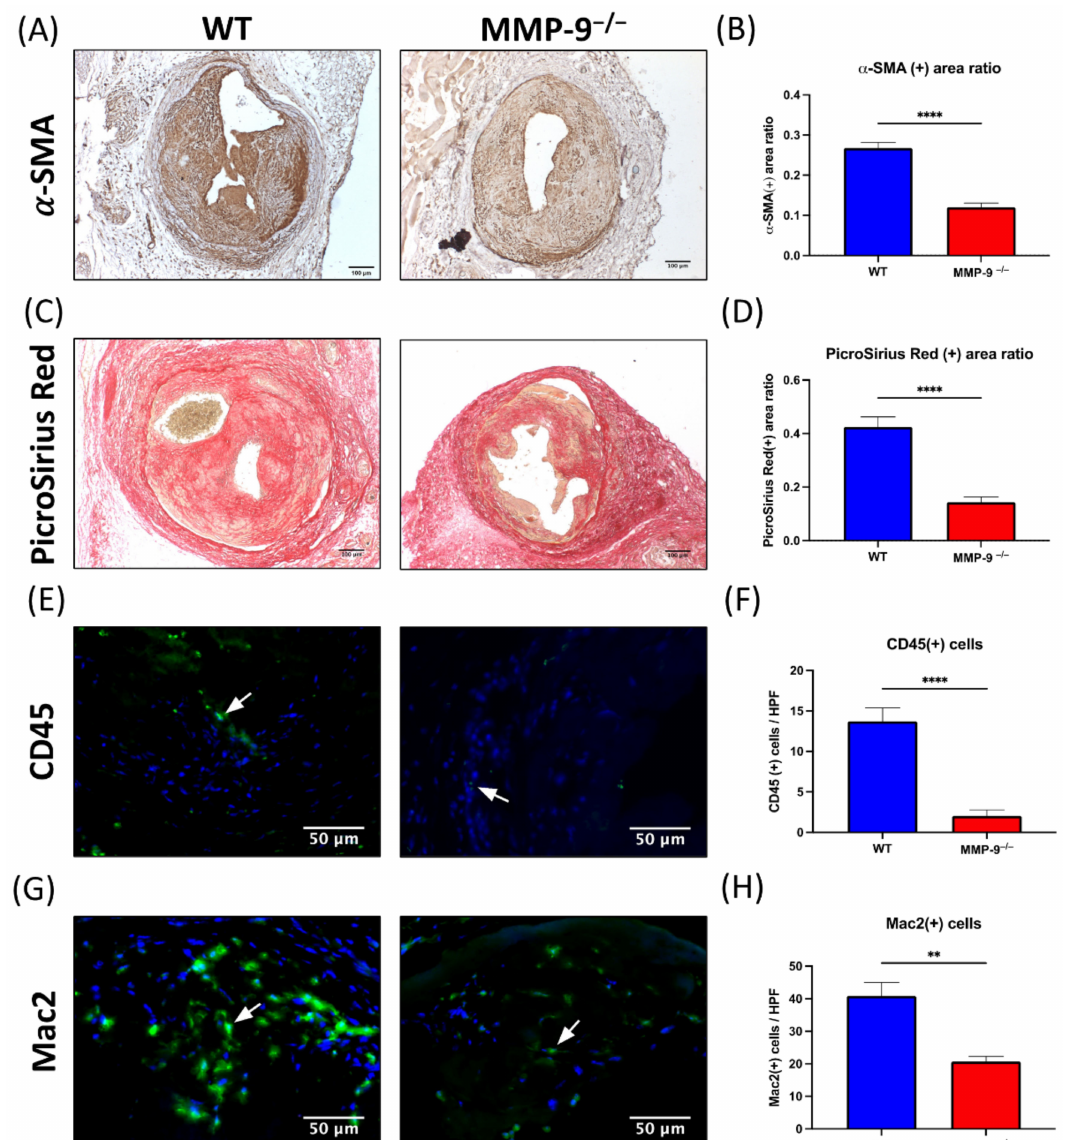
Figure 4. Matrix metalloproteinase 9 (MMP-9) knockout reduced α -smooth muscle actin ( α -SMA) antibody and Picro Sirius stained area, and CD45(+) and Mac2(+) cells in neointima of AV fistula venous segment. ( A ) α -SMA(+) cells were the major cellular component within neointima. ( B ) The α -SMA(+) area ratio in neointima reduced after MMP-9 knockout ( p < 0.0001). ( C ) Extracellular component of neointima was assessed with Picro Sirius Red staining. ( D ) The Picro Sirius Red(+) area ratio within neointima decreased in MMP-9 − / − mice ( p < 0.0001). ( E ) Leukocyte infiltration within neointima was determined by CD45 immunofluorescence. ( F ) MMP-9 deletion decreased CD45(+) cells/HPF in neointima ( p < 0.0001). ( G ) Macrophages in the neointima was examined by Mac2 immunofluorescence. ( H ) The number of Mac2(+) cells/HPF decreased in MMP-9 − / − mice ( p = 0.0011). White arrows indicated positively stained cells. ** p < 0.01, **** p < 0.0001. Data presented as mean ± SEM. Data analyzed by Student’s t -test one-way, n = 6–7 in each group. HPF, high power